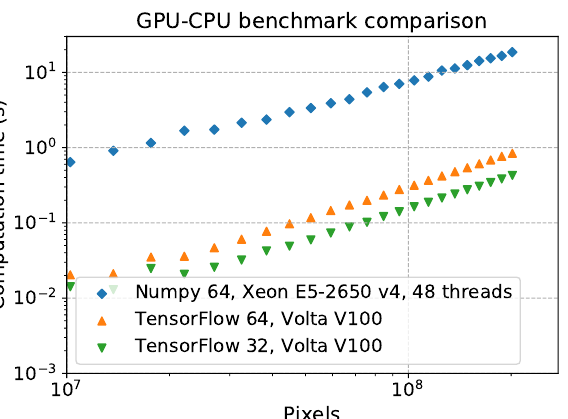
Figure 5. A simple benchmark on two example devices: an Intel Xeon E5-2650 v4 CPU system with, in total, 24 2.20 GHz cores and 48 threads, and a NVIDIA Volta V100 with 5120 cores at 1500 MHz. The test is based on the generation of two random 2-rank arrays and a matrix multiplication between them. The green and orange dots show the benchmark conducted, respectively, with 64 and 32 bit data with TensorFlow, the blue ones come from a test with 64 bit data with Numpy. The test with the CPUs has been performed keeping the multithreading enabled as by default for